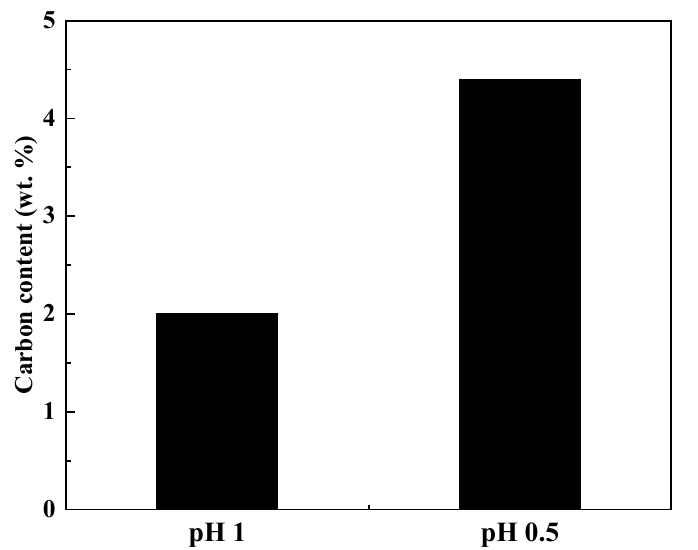
Figure 5. pH effect of a trivalent Cr bath on the carbon content in electrodeposited Cr coating. Reprinted with permission from [83]. Copyright 2010 Elsevier